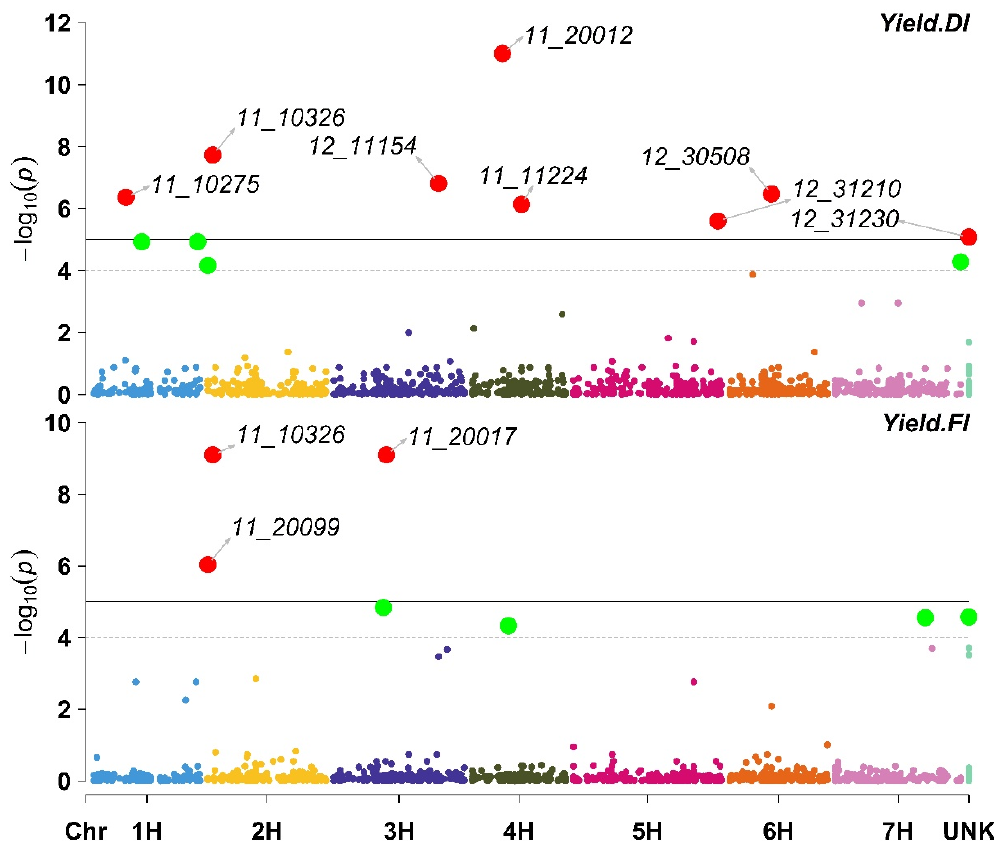
Figure 6. Manhattan plot displaying the results of the genome-wide association scan (red dots annotated dots refer to significant markers or markers with − log10 (p) more than 5, while the green dots refer to non-significant markers but have −log10 (p) between 4 and 5) for grain yield (Yield) using 426 barley lines under Deficit Irrigation (Yield. DI, upper plot) and Full Irrigation (Yield. FI, lower plot).